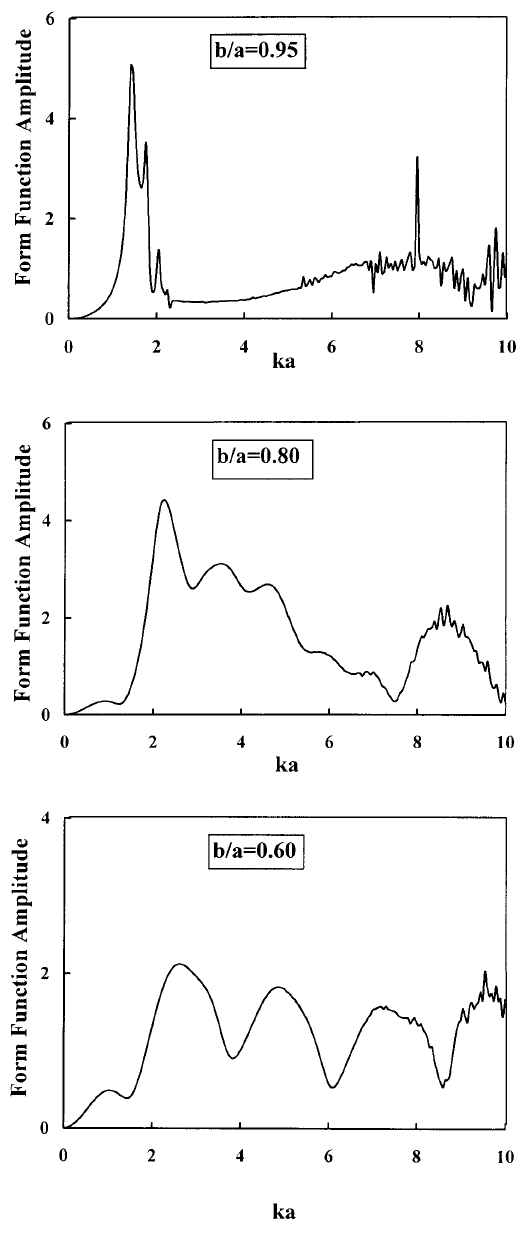
Fig. 6. Form function amplitude versus nondimensional frequency for a hollow duraluminium sphere immersed in water. wide frequency range, are displayed in Figs 2a and 2b of [34], respectively. Polymer 18 is found to have the